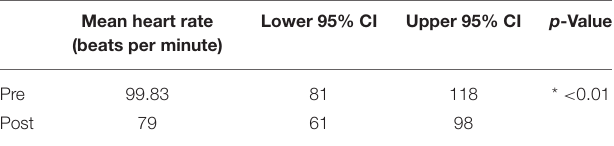
Frontiers in Veterinary Science |